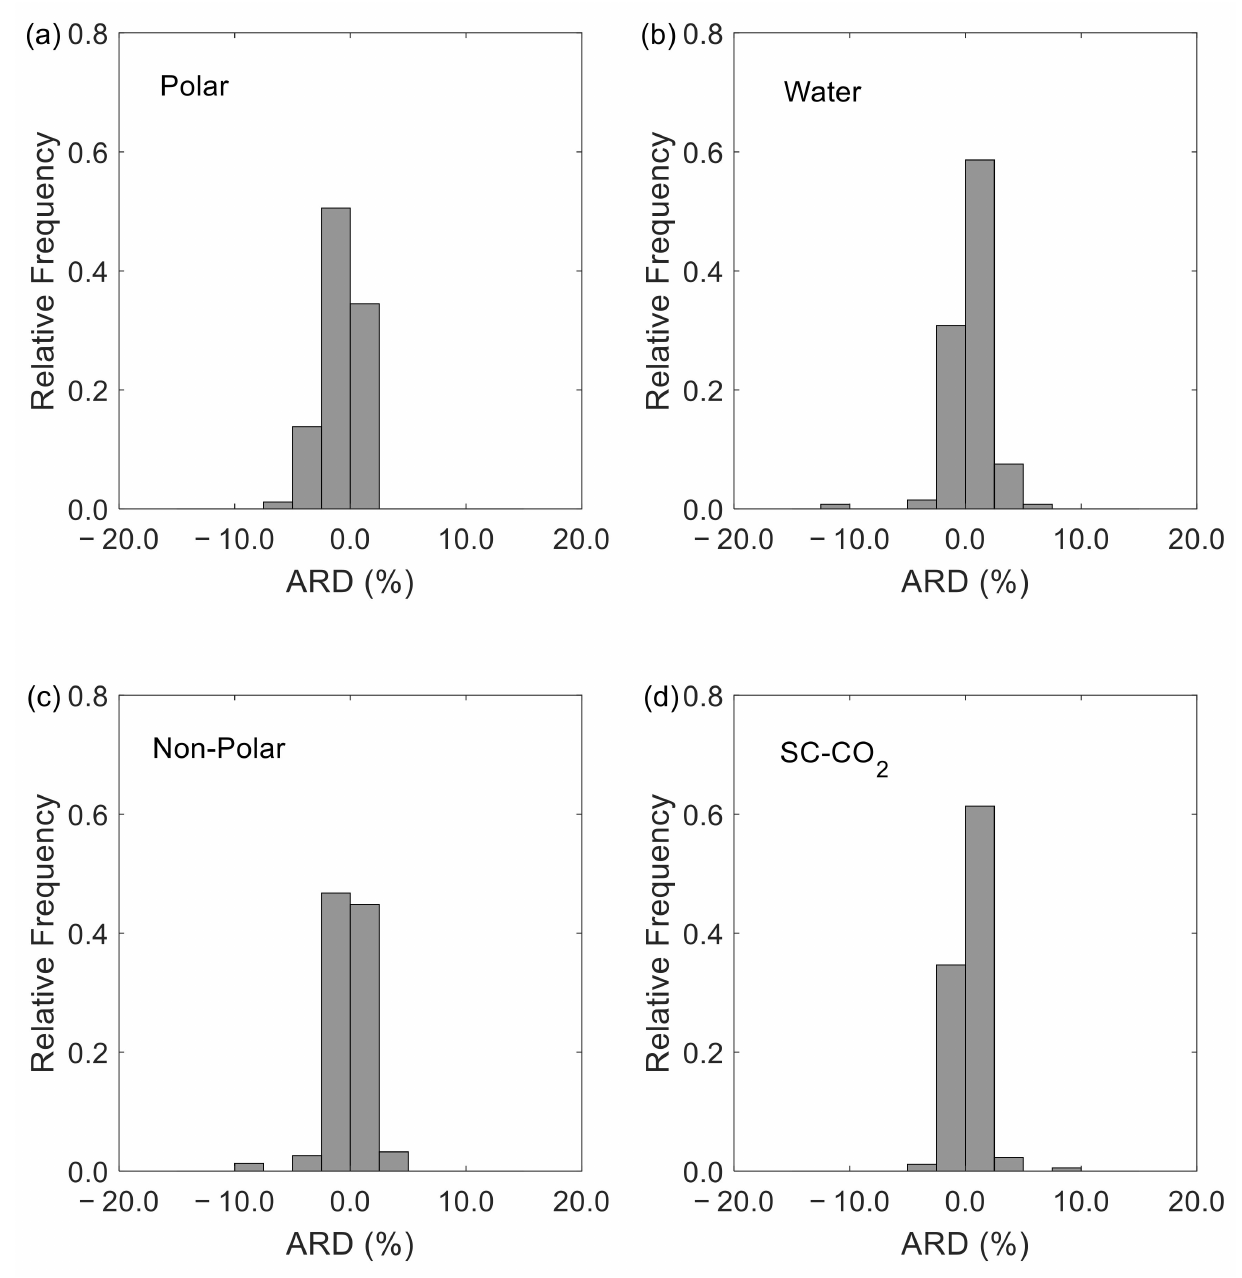
Figure 2. ARD histograms with bin sizes of 2.5% for systems with: ( a ) polar solvents, excluding water; ( b ) water as solvent; ( c ) non-polar and weakly polar solvents, excluding SC-CO 2 ; and ( d ) SC-CO 2 as